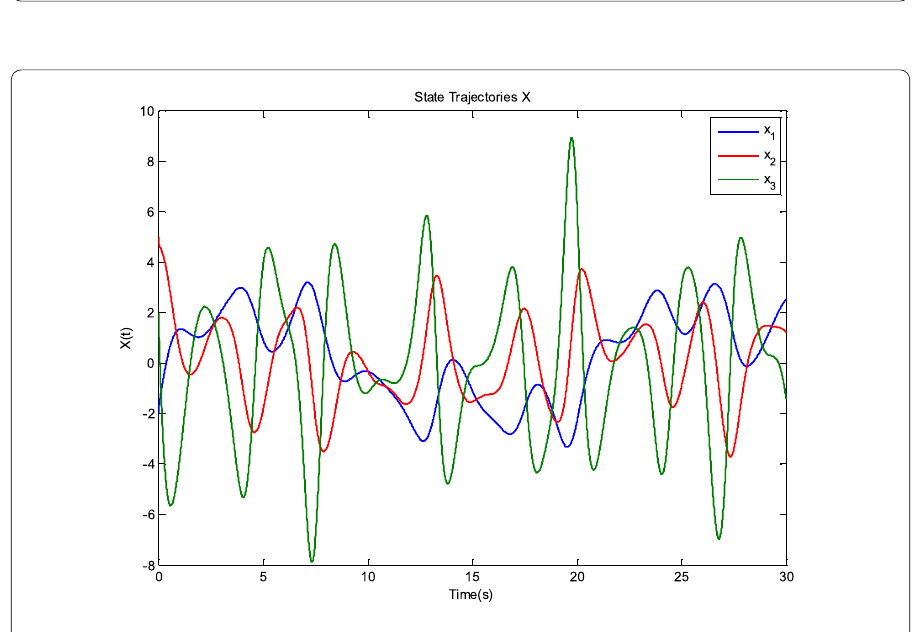
Figure 9 Chaos in Arneodo fractional system